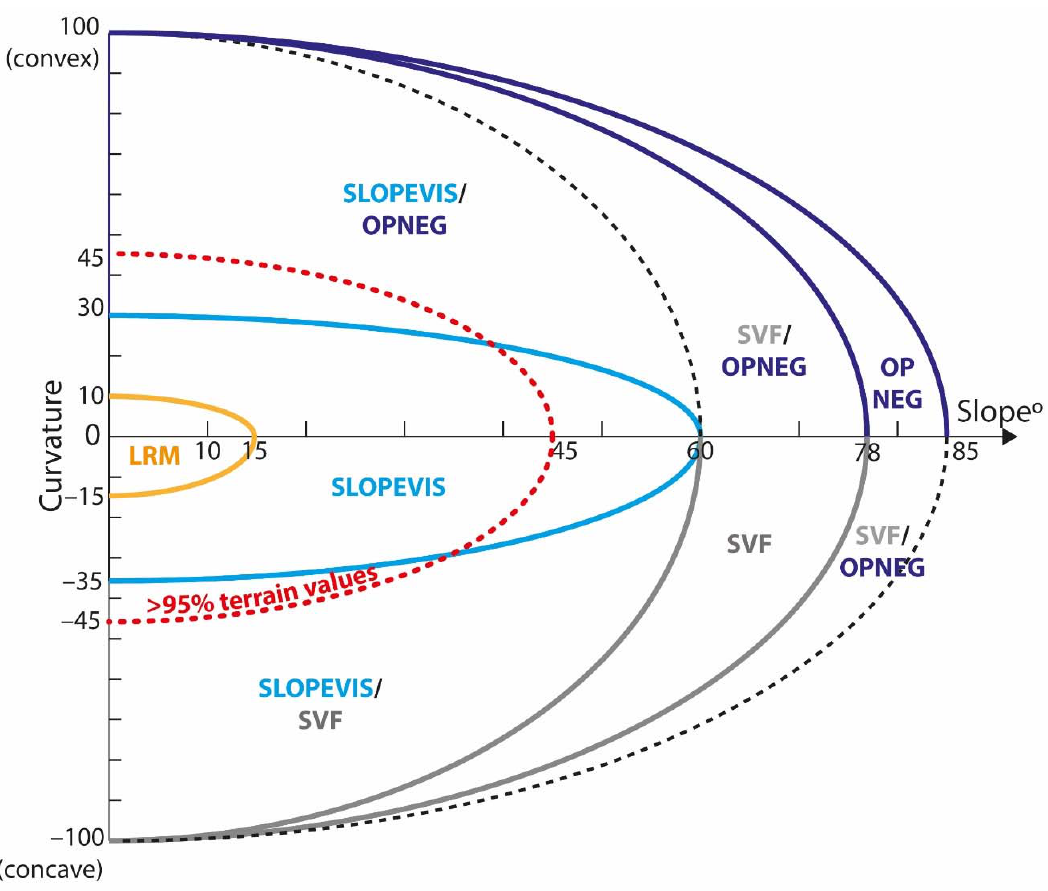
Figure 10. Idealized representation of best VT choice (high contrast and low noise) depending on slope and curvature parameters. Rugosity (SRR) was not considered due to its similarity to curvature. Red dashed line contains most terrain values (95% or more) in normal datasets. When two methods can be considered optimal depending on what amount of noise is acceptable, both are indicated. The black dashed line represents diffuse transitions between these areas.